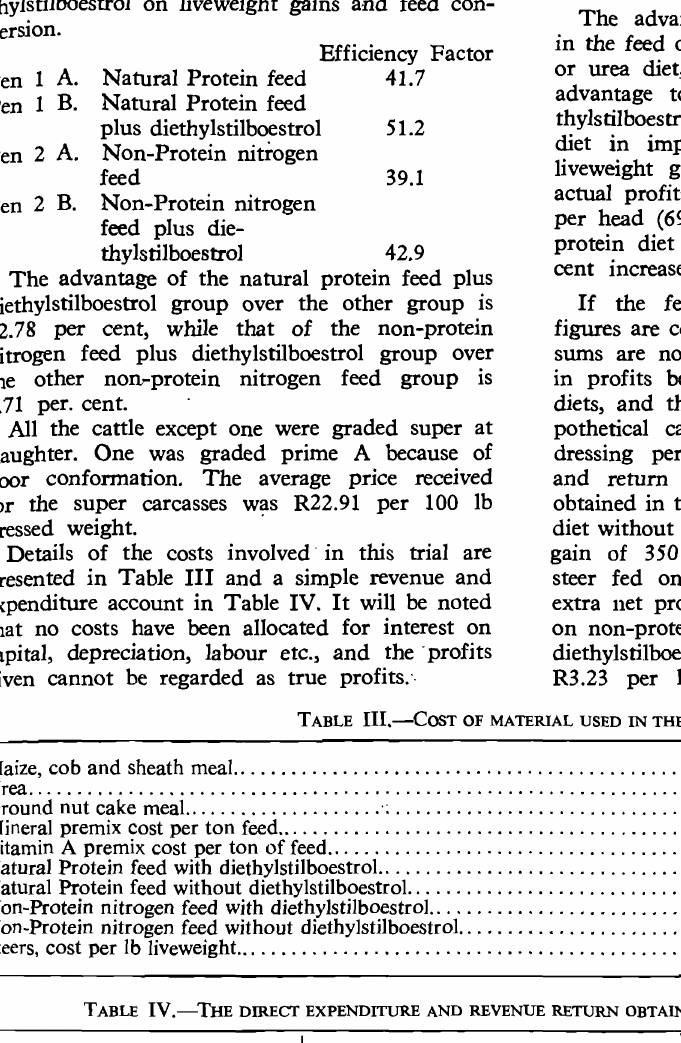
TABLE IV.-THE DIRECT EXPENDITURE AND REVENUE RETUlU< OBTAINED IN THE TRIAL PER 10